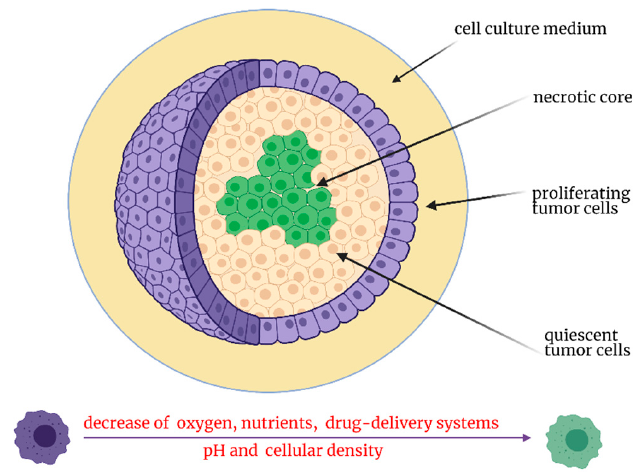
Figure 4. Schematic representation of a 3D multicellular tumor spheroid.